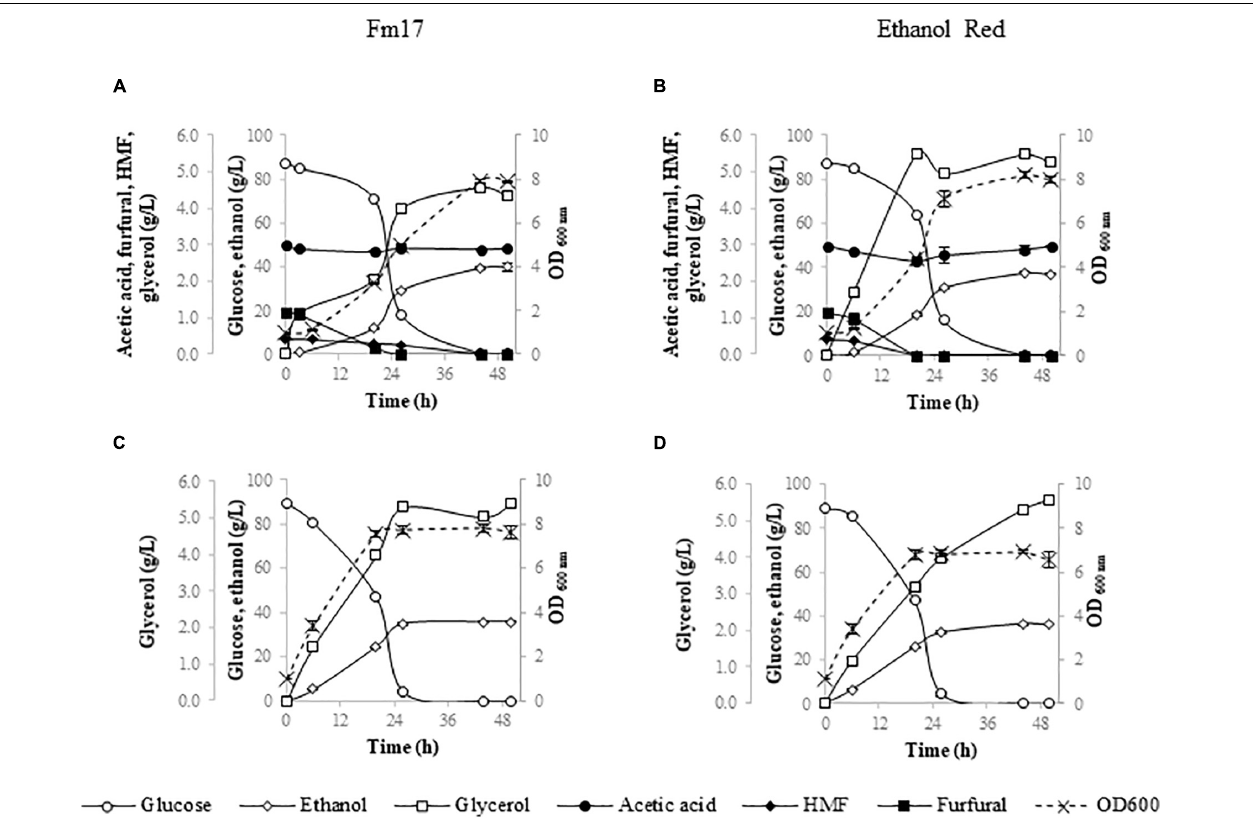
FIGURE 3 | Fermentation performances of Saccharomyces cerevisiae strains in YNB broth containing 92 g/L of glucose with or without the addition of pre-hydrolysate Pa3 from Phragmites australis : Fm17 ( A : supplemented with Pa3, C : reference broth not supplemented with Pa3) and Ethanol Red ( B : supplemented with Cc3, D : reference broth not supplemented with Pa3). The acidity of the medium was adjusted to pH 5.0 with NaOH. The experiment was conducted in triplicate. Error bars correspond to the standard deviation of the